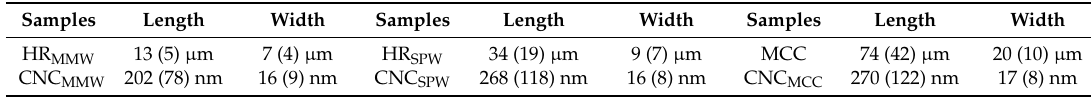
Table 2. Particle size of HR MMW , HR SPW , MCC, and their CNCs.